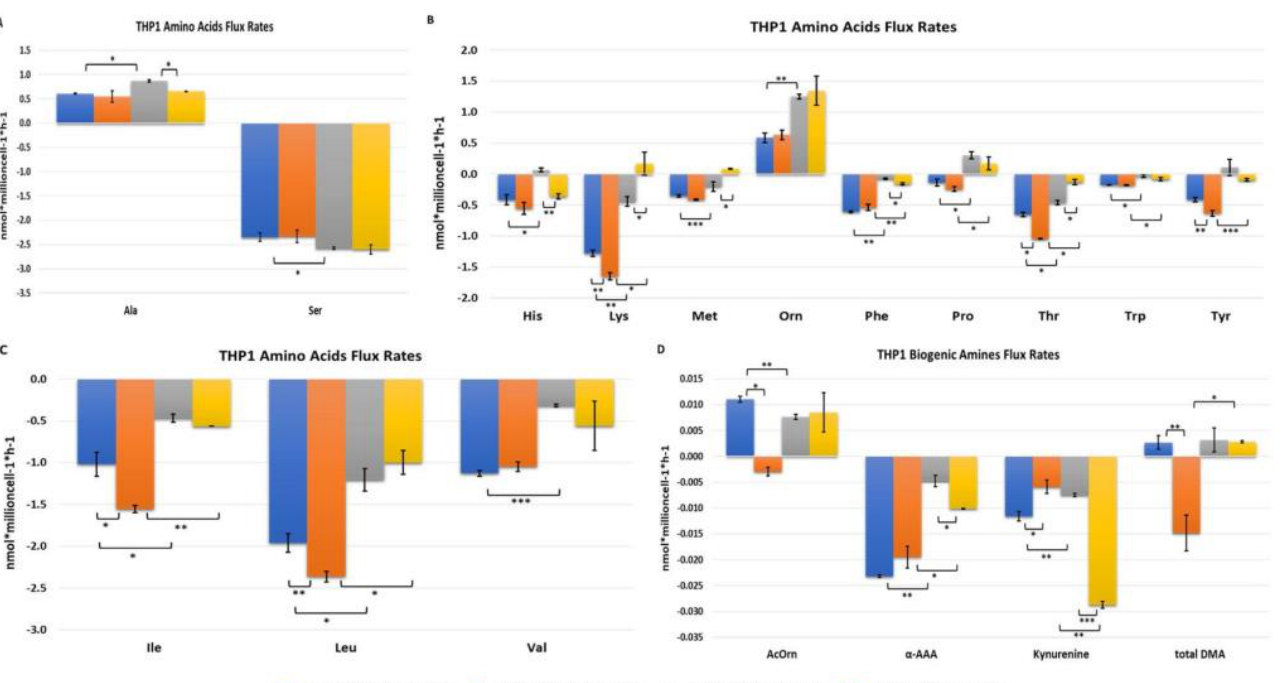
Figure 6. Changes in concentration of specific metabolites measured in incubation medium of THP- 1 WT and THP-1 KD cells incubated for 48 h, for both normoxic and hypoxic conditions. All changes in concentrations were normalized by cell number and incubation time. Negative values denote a decrease in concentration during incubation time, and a positive value denotes an increase in concentration during incubation time. ( A ) Alanine and serine. ( B ) Branched-chain amino acids isoleucine (Ile), leucine (Leu) and valine (Val). ( C ) Histidine (His), lysine (Lys), methionine (Met), ornithine (Orn), phenylalanine (Phe), proline (Pro), threonine (Thr), tryptophan (Tryp) and tyrosine (Tyr). ( D ) Acetylornithine (AcOrn), alpha-aminoadipic acid ( α AAA), kynurenine and total dimethylarginine (total DMA). Data represented are mean ± SD (n = 3). Statistically significant differences were determined by two-tailed independent sample Student’s t -test with p -values of p < 0.05 (*). p < 0.01 (**) and p < 0.001